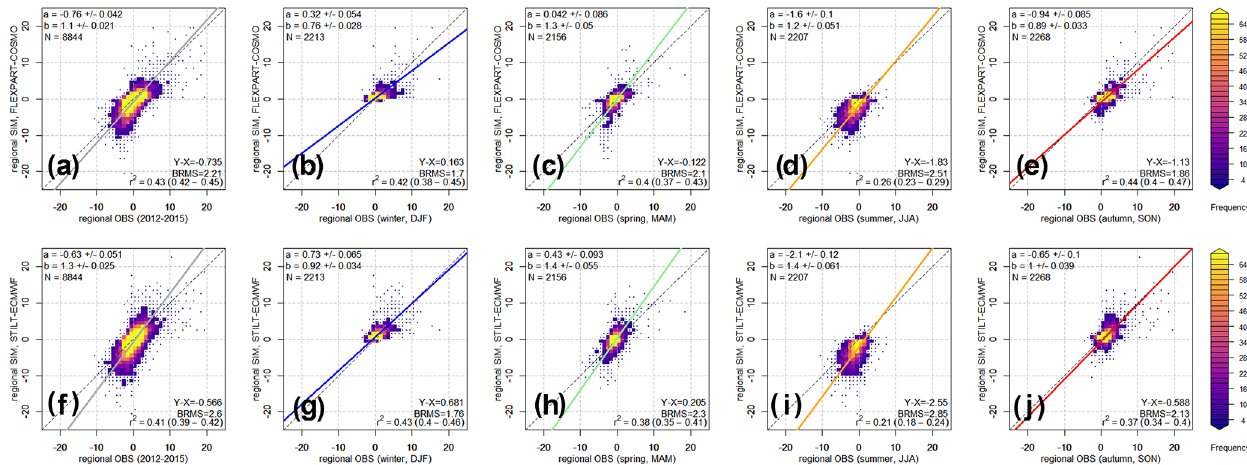
Figure 5. Heat maps for CO 2 .regional simulations (SIM) using FLEXPART–COSMO ( a–e ) and STILT-ECMWF ( f–j ) in comparison to regional components of observations (OBS) for 2012–2015 (full year and per season) at 3-hourly time resolution. The STILT-ECMWF- based JCS background is subtracted from the observations to derive the regional component. The weighted least squares regression takes into account uncertainties in both data sets (the full-page version of this figure is available in the Supplement).